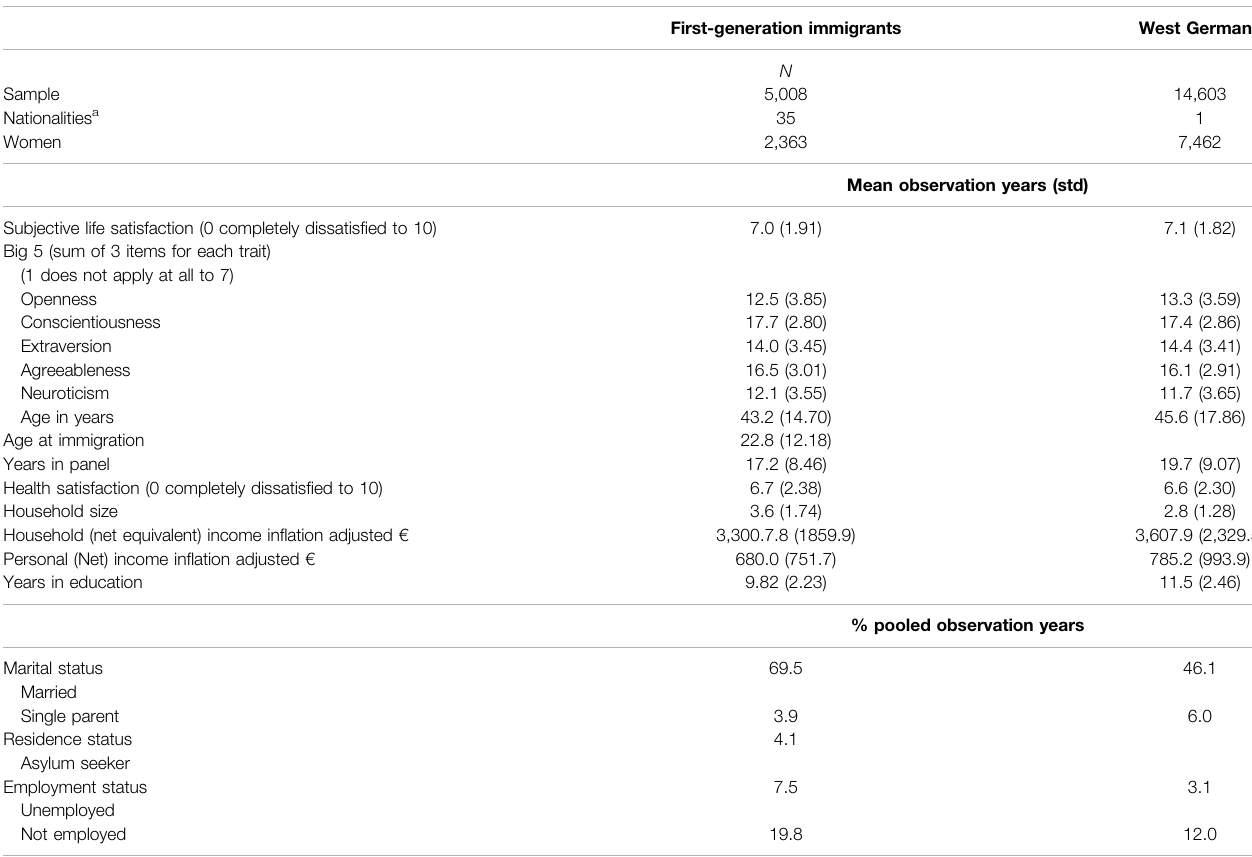
TABLE 1 | Pooled SOEP samples A-D 1984 –